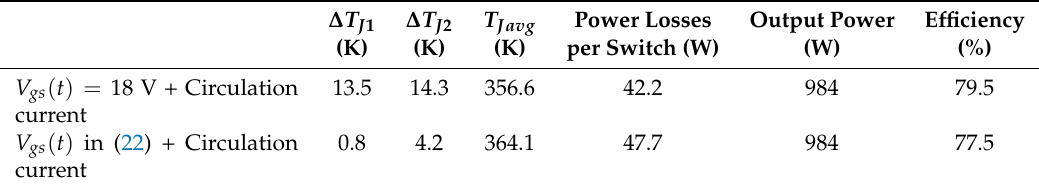
Table 7. Performance evaluation at low speed operation with 40 kHz switching frequency and 8 kHz circulation current. ∆ T ∆ T J 1 J 2 T Javg Power Losses Output Power